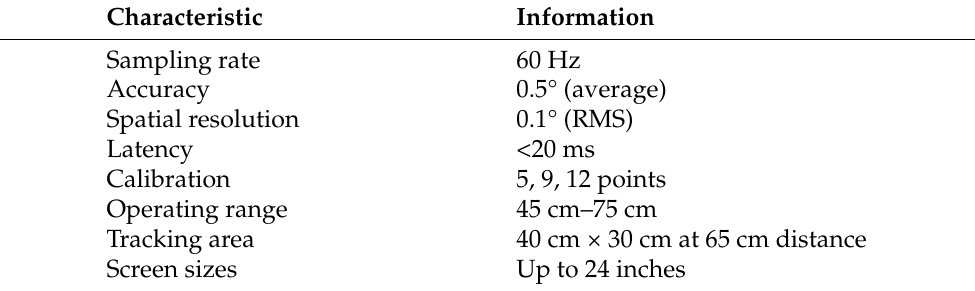
Table 2. Technical characteristics of the Eye Tribe